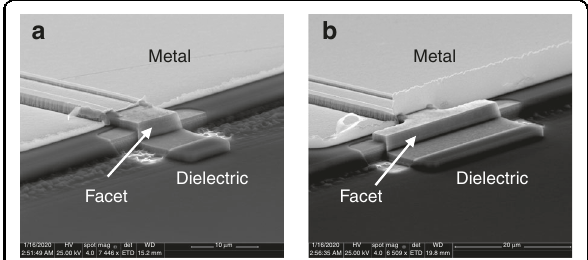
Fig. 10 Scanning electron microscopy image. a Rectangular or b T-shape etched diode-laser facets. The different facet geometries were used to evaluate the impact of scattering at the facet edges. Adapted with permission from ref. 109 . © Optical Society of America